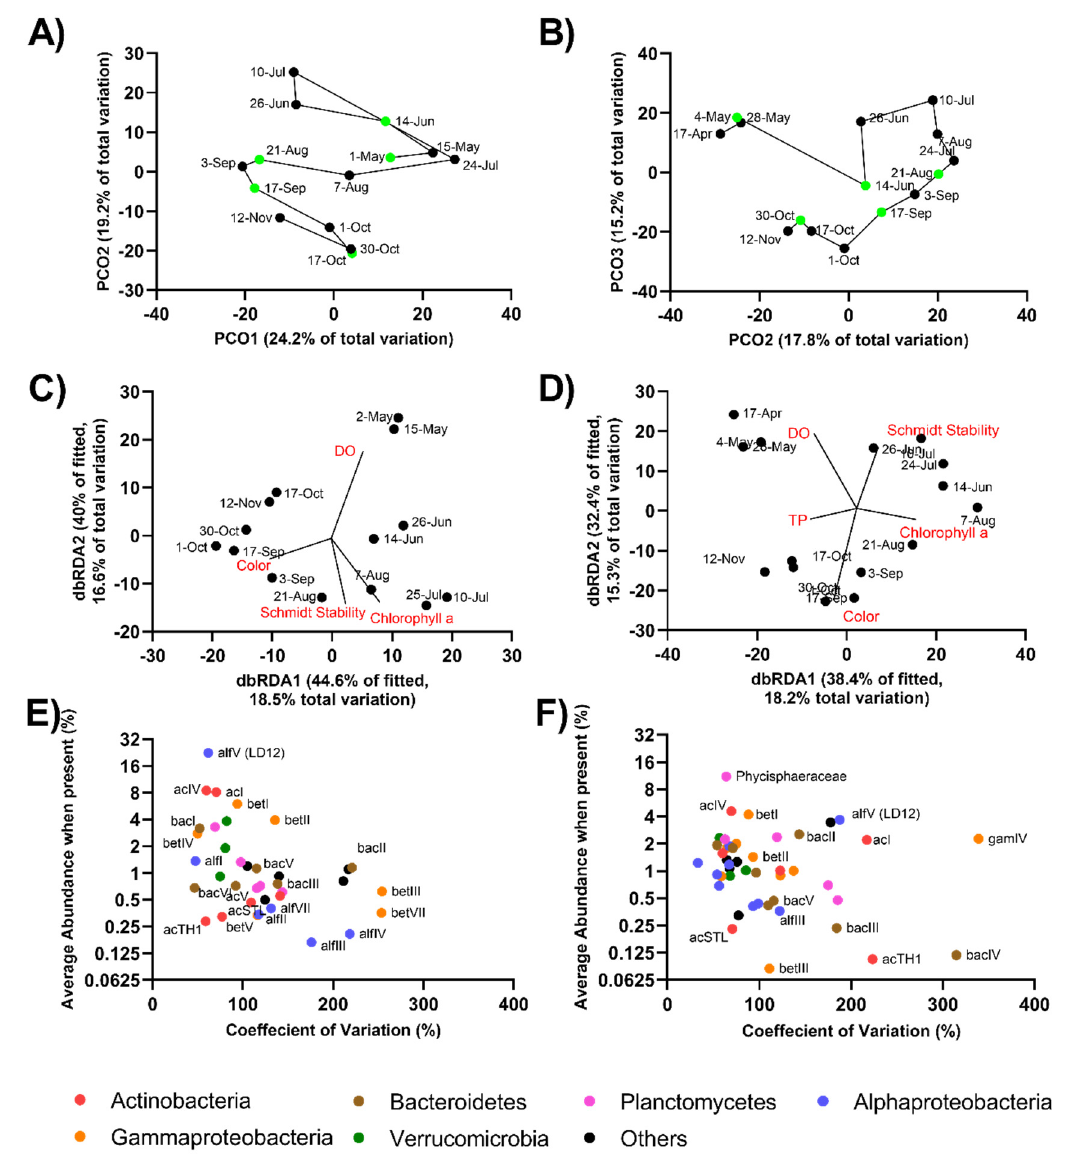
Figure 5. Temporal dynamics of free-living ( A , C , E ) and particle-associated ( B , D , F ) communities in Lough Feeagh. ( A , B ) Principal Coordinate analysis depicting Bray–Curtis similarities (green points represent weather events (Table 1)). ( C , D ) Distance-based linear models depicting the relative contribution of environmental variables to the respective bacterial community composition. ( E , F ) Relative abundance of freshwater families as a function of their coefficient of variation.